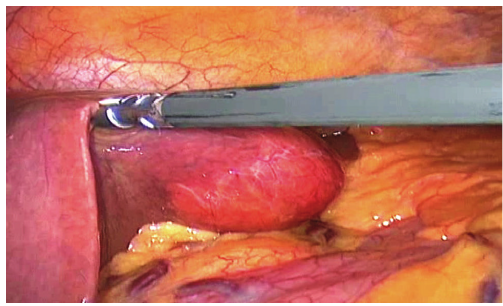
Figure 3: Intraoperative image of liver resection.